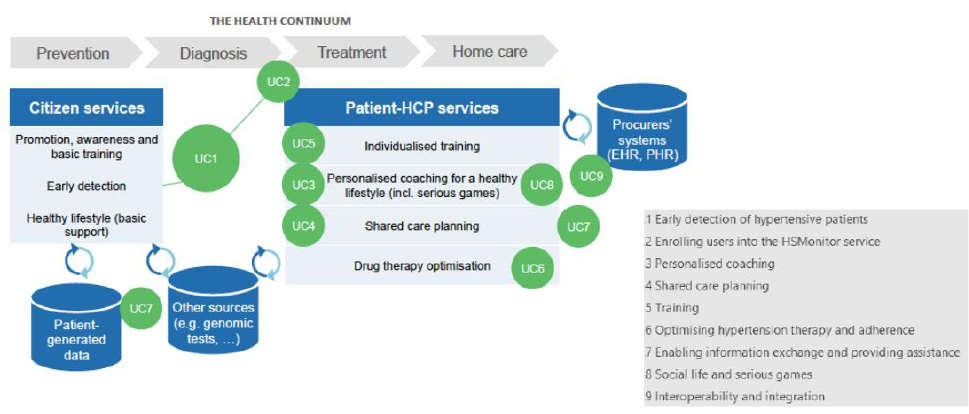
Figure 6. Use cases and process models covering all HSMonitor aspects.